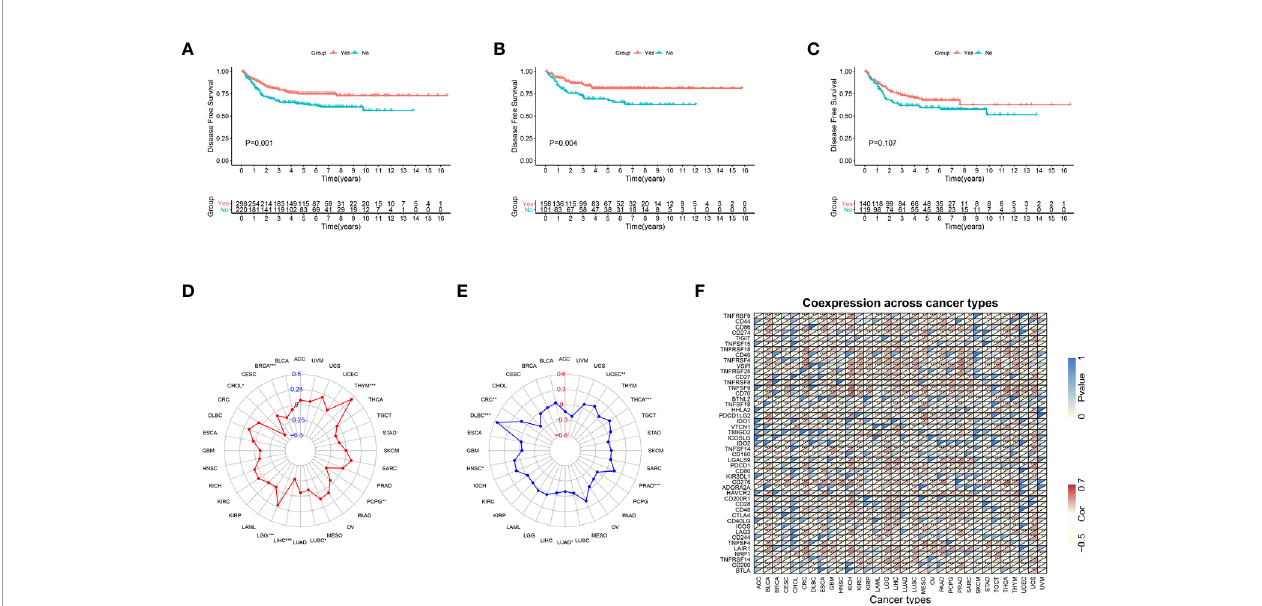
FIGURE 11 | Kaplan – Meier plots and pan-cancer analysis. (A) CRC patients who underwent adjuvant chemotherapy had a signi fi cantly better disease-free survival. (B) CRC patients with lower FSTL3 could bene fi t from adjuvant chemotherapy. (C) CRC patients with high FSTL3 would gain limited bene fi t from adjuvant chemotherapy. (D) FSTL3 expression levels are correlated with TMB among multiple types of cancers, but not including CRC. (E) The radar plot shown that FSTL3 expression is associated with MSI among CRC. (F) FSTL3 expression level is signi fi cantly correlated with the expression of immune checkpoint molecules in the vast majority of cancers. * P < 0.05, ** P < 0.01, *** P <